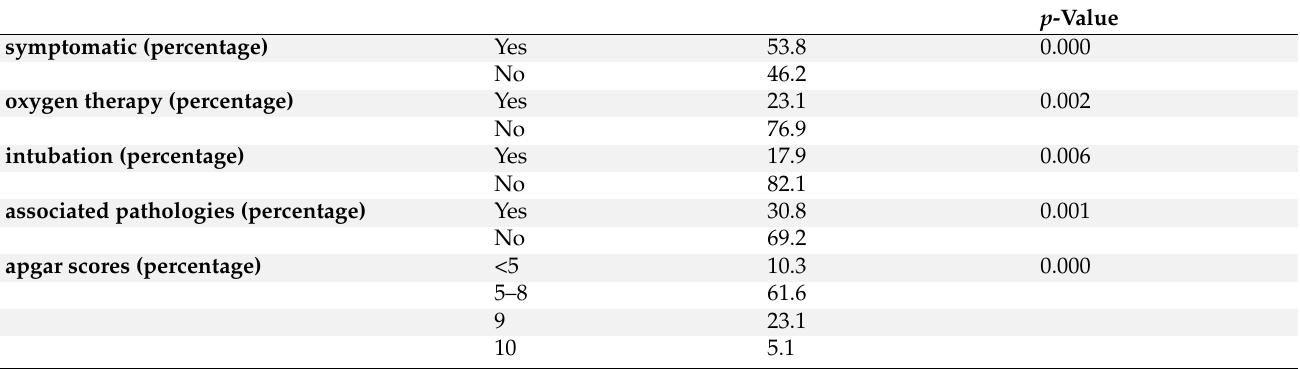
Table 2. Characteristics of COVID-19-positive patients and